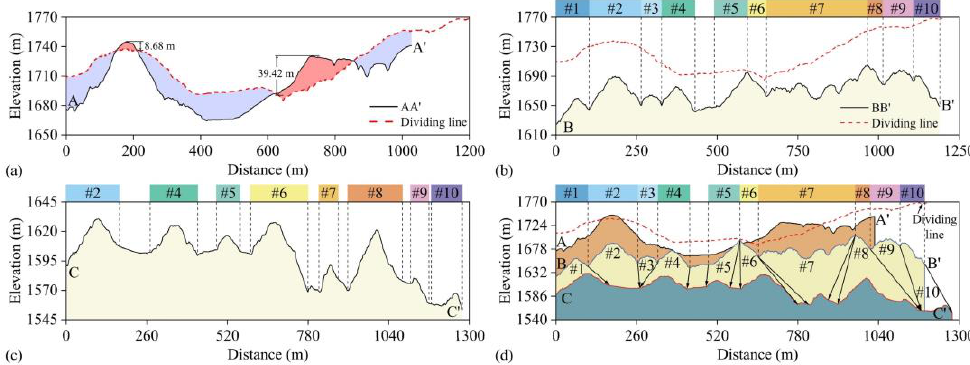
Figure 8. Results of the longitudinal section lines’ elevation analysis, ( a ) the elevation change of the longitudinal section line 𝐴𝐴′ , ( b ) the elevation change of the longitudinal section line 𝐵𝐵′ , ( c ) the elevation change of the longitudinal section line 𝐶𝐶′ , and ( d ) the elevation change trend of the three longitudinal section lines.